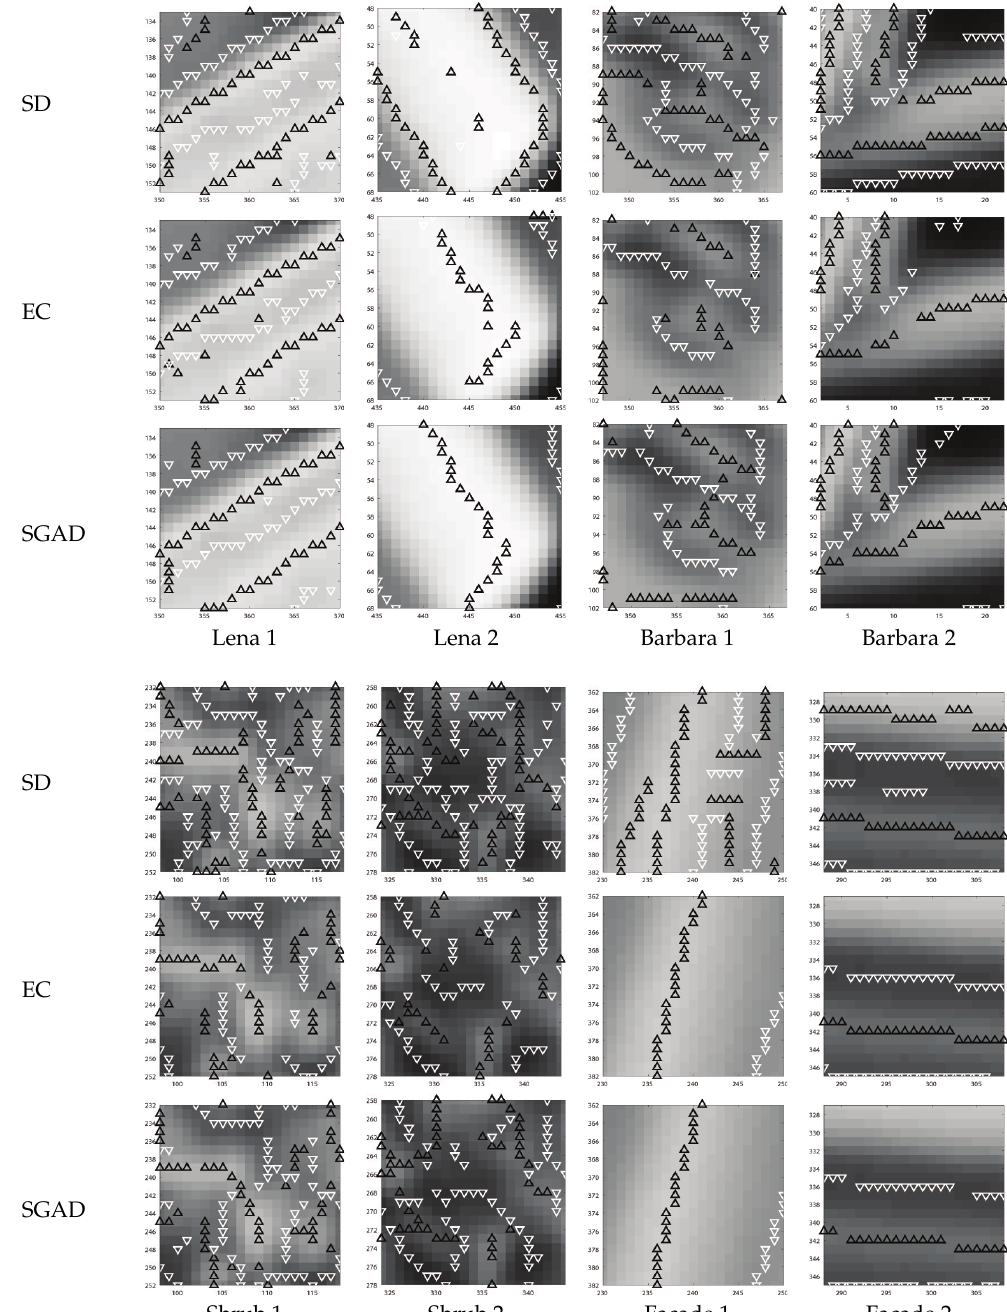
Figure 9. Line-detection results obtained using the SD-, EC-, and SGAD-based methods for the original images. Ridge and valley pixels are denoted by upward-pointing black and downward-pointing white triangles,